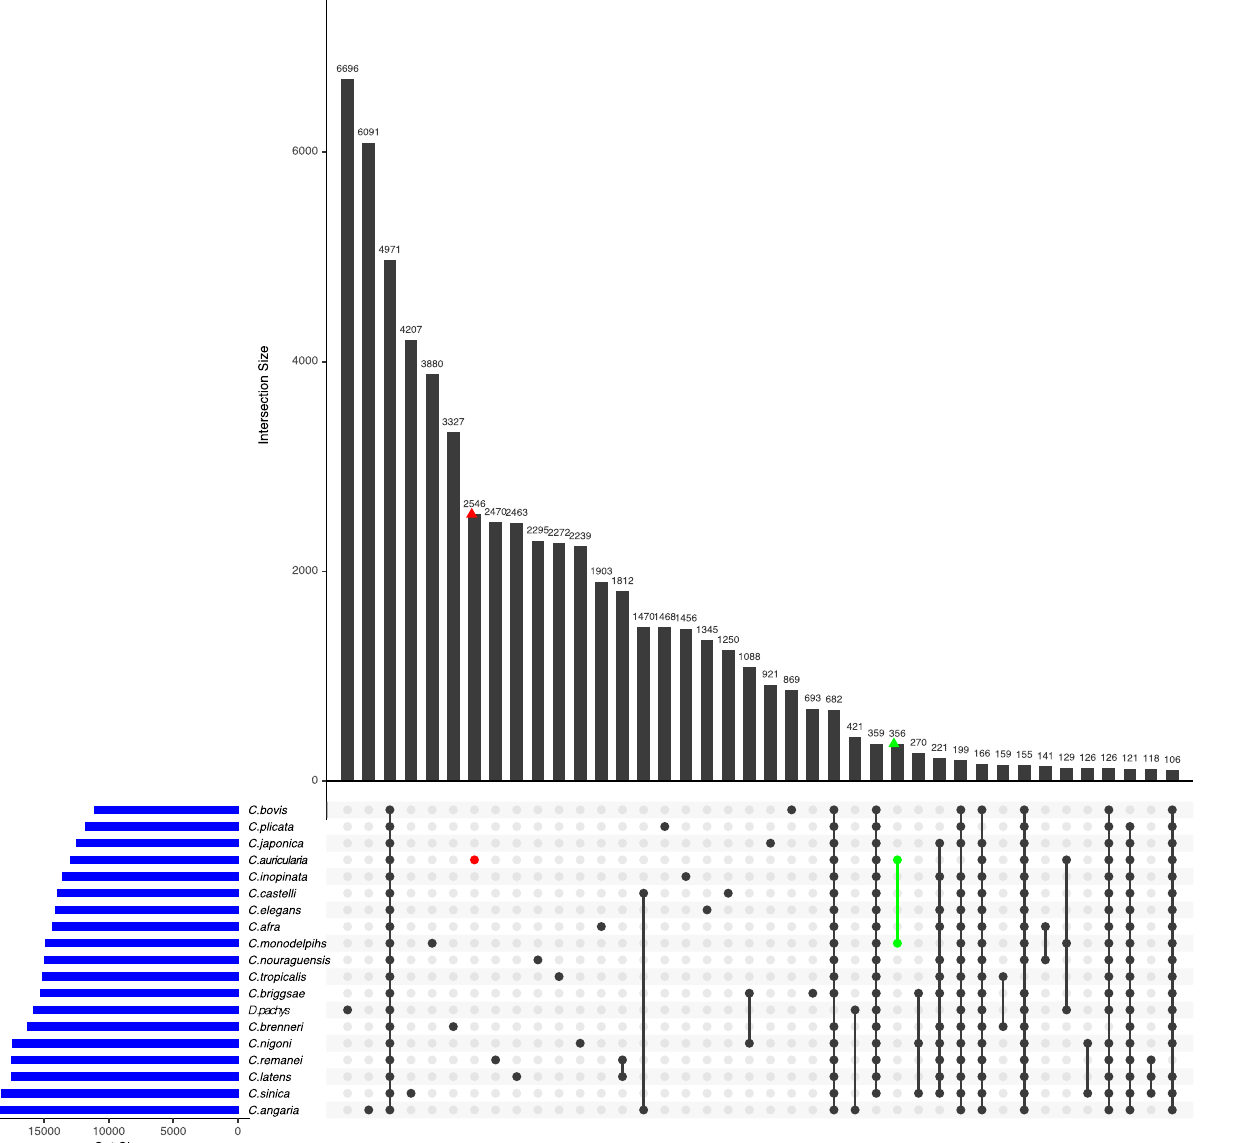
Figure 5. Orthologue comparison across the 18 Caenorhabditis and D. pachys genomes. UpSetR plot showing unique and overlapping protein ortholog clusters. The intersection matrix is sorted in descending order. Blue bars represent the orthogroup size for each genome and connected dots represent intersections of overlapping orthogroups while vertical bars show the size of each intersection. Orthogroups unique to C. auriculariae and C. auriculariae-C. monodelphis are shown in red and green,